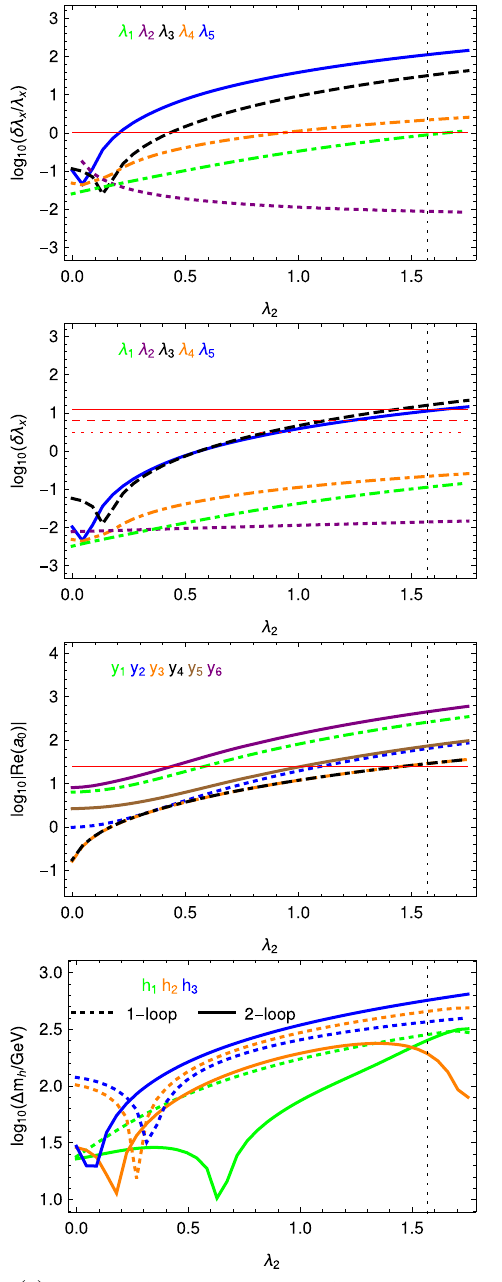
( a ) The size of the different loop effects. See Fig. 3 for more details. Here,the vertical black lines shows the tree-level unitarity constraints. Fig. 8 Perturbativity limits as function of λ 2 . The other parameters are chosen as: λ 3 = 0 . 5, λ 4 = − 0 . 1, λ 5 = 0 . 1, α = 20 ◦ , s H = 0 . 25, m H = 600